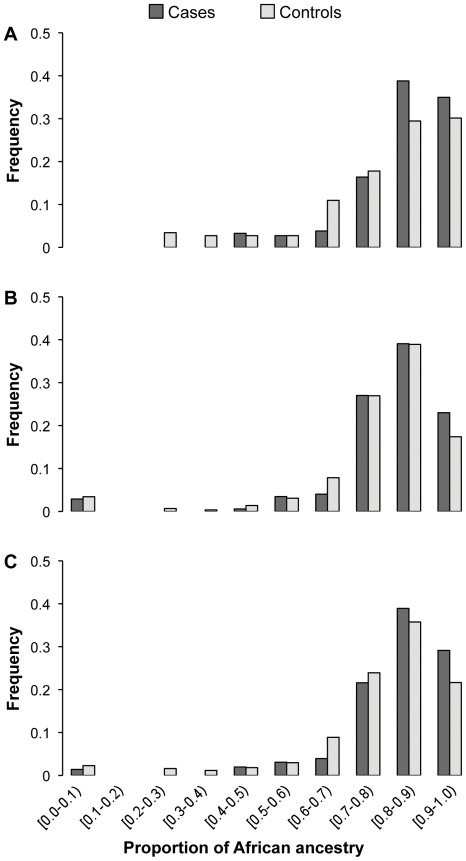
Histograms representing the proportion of individual African ancestry estimates based on 95 AIMs for REACH (A), BASS (B), and overall case-controls (C).